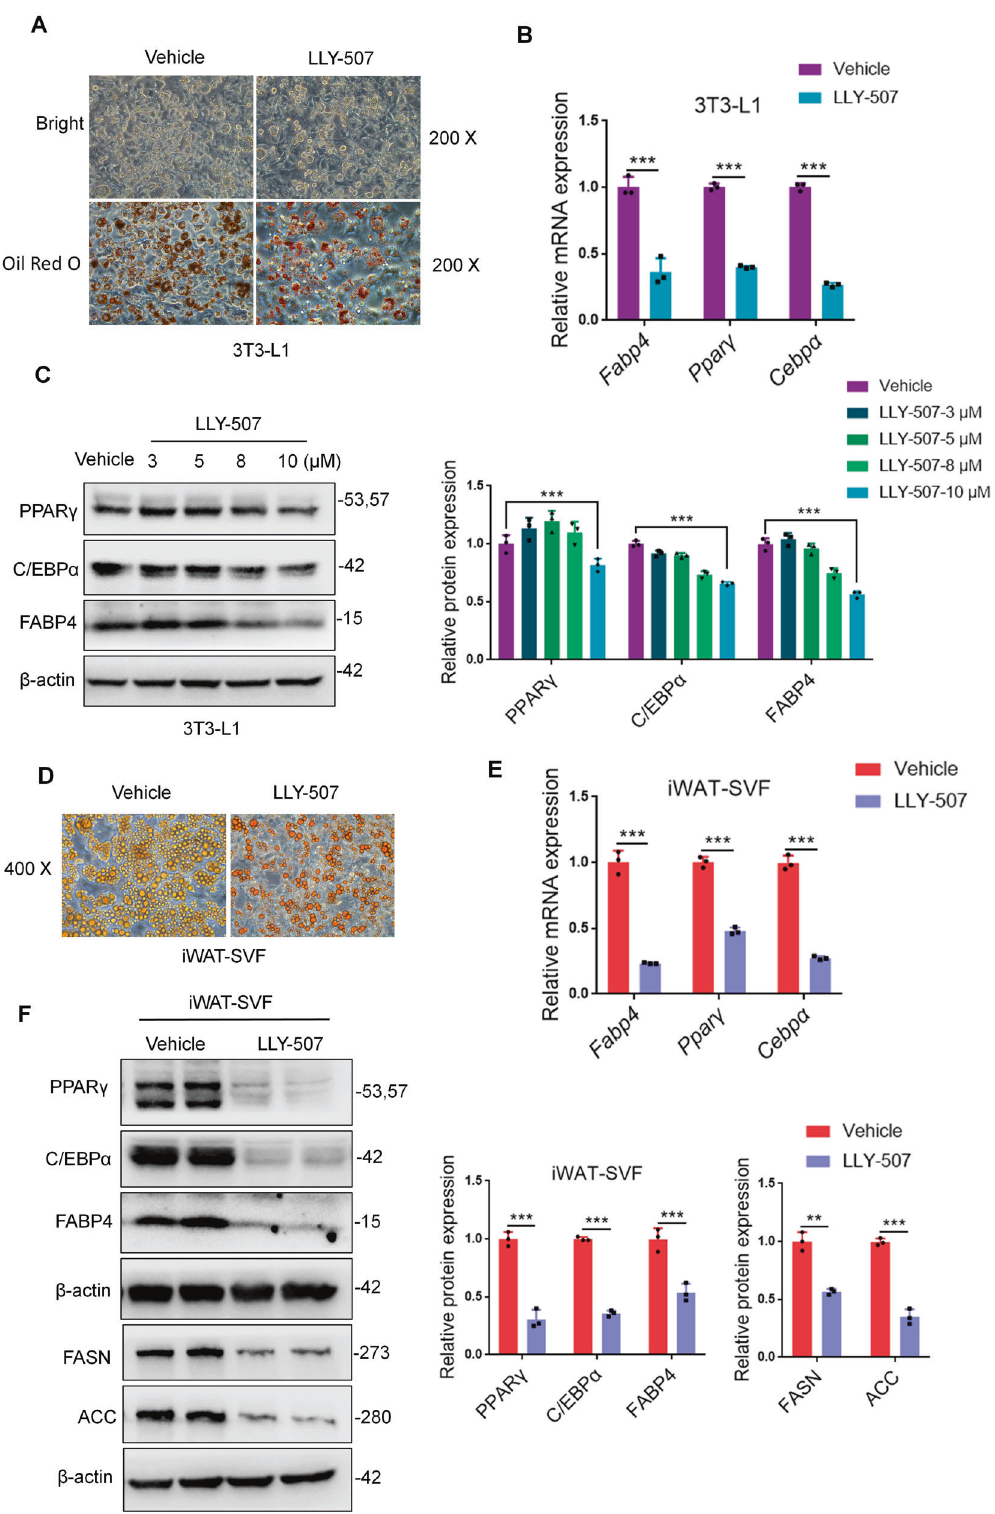
Fig. 4 LLY-507, a potent and selective inhibitor of Smyd2, restrains adipocyte differentiation in vitro. 3T3-L1 preadipocytes or iWAT-SVF were treated with LLY-507 and meanwhile differentiated into mature adipocytes. A The Oil Red O staining of 3T3-L1 adipocytes. Magni fi cation ×200. B The mRNA levels of adipogenesis markers ( Ppar γ , Cepb α , and Fabp4 ) in 3T3-L1 adipocytes. C The protein expressions of adipogenesis markers (PPAR γ , C/EBP α , and FABP4) in 3T3-L1 adipocytes treated with LLY-507 in a dose-dependent manner. D The Oil Red O staining of iWAT- SVF differentiated adipocytes. Magni fi cation ×400. E The mRNA levels of adipogenesis markers ( Ppar γ , Cepb α and Fabp4 ) in iWAT-SVF differentiated adipocytes. F The protein expressions of adipogenesis markers (PPAR γ , C/EBP α and FABP4) and the rate-limiting enzyme in adipogenesis (ACC and FASN) in iWAT-SVF differentiated adipocytes. Data are presented as mean ± SD. ** p < 0.01, *** p < 0.001.